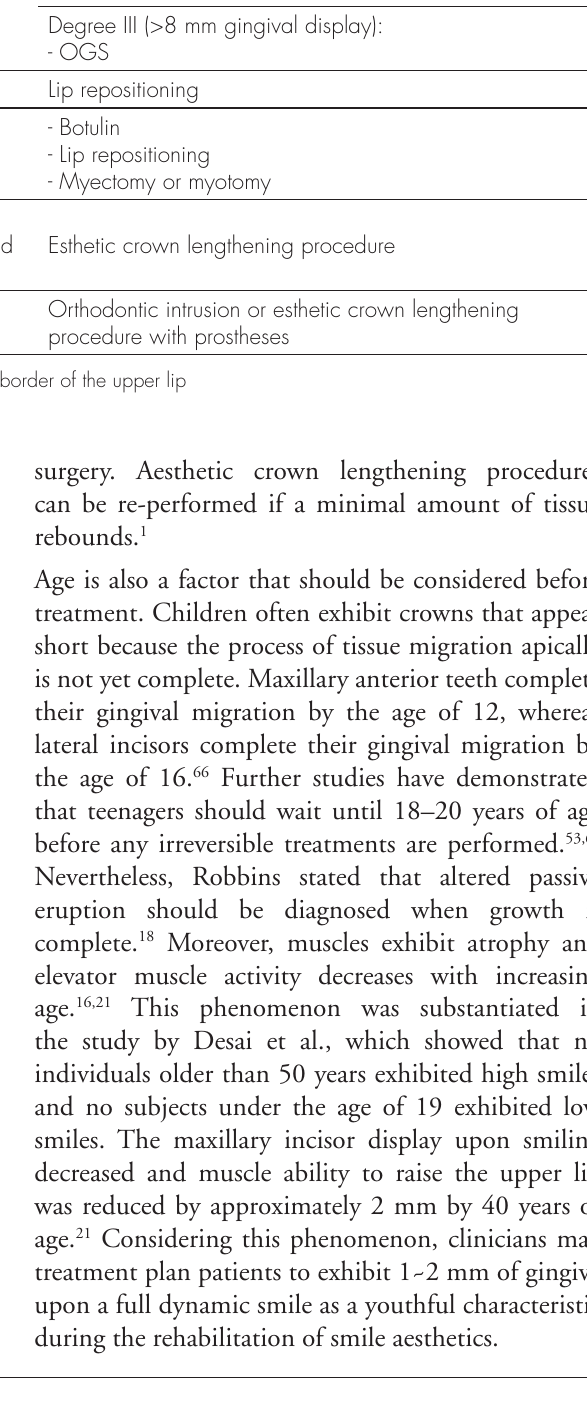
Table I. Management of gingival excess.